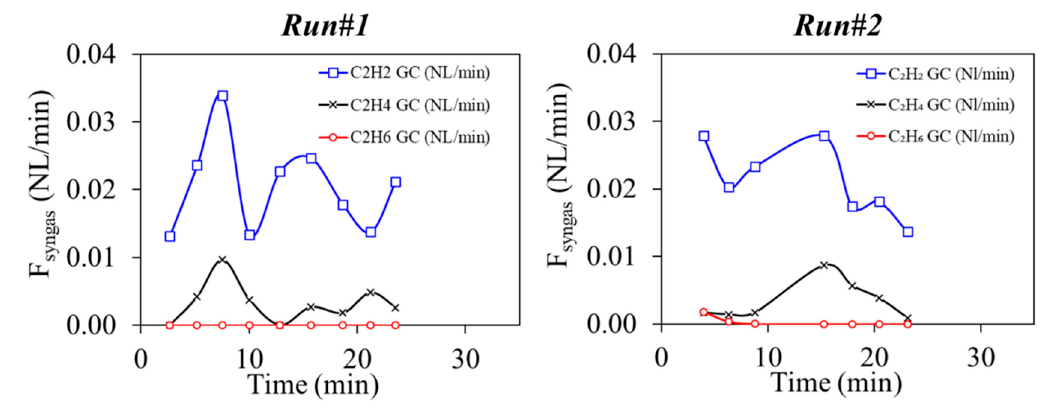
Figure 5. GC analysis of C n H m during Runs#1,2.